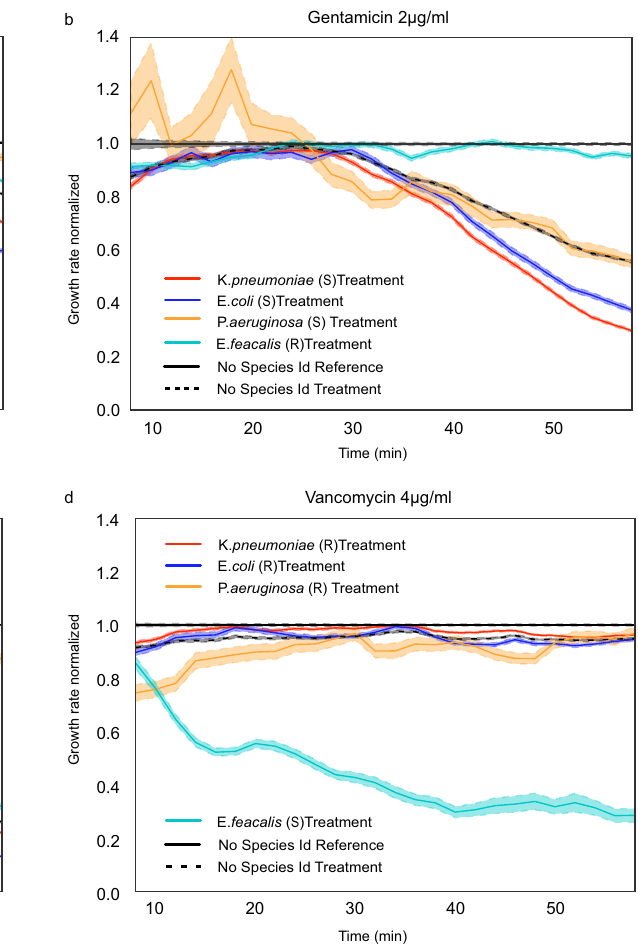
Fig. 3 | Species strati fi ed responses to antibiotic treatments. a – d AST pro fi les with normalized growth rates for the four antibiotics used. The species strati fi ed responses (mean and SEM), as well as the pooled response (without species stra- ti fi cation), are shown for each antibiotic. In all AST pro fi le plots, S and R represent